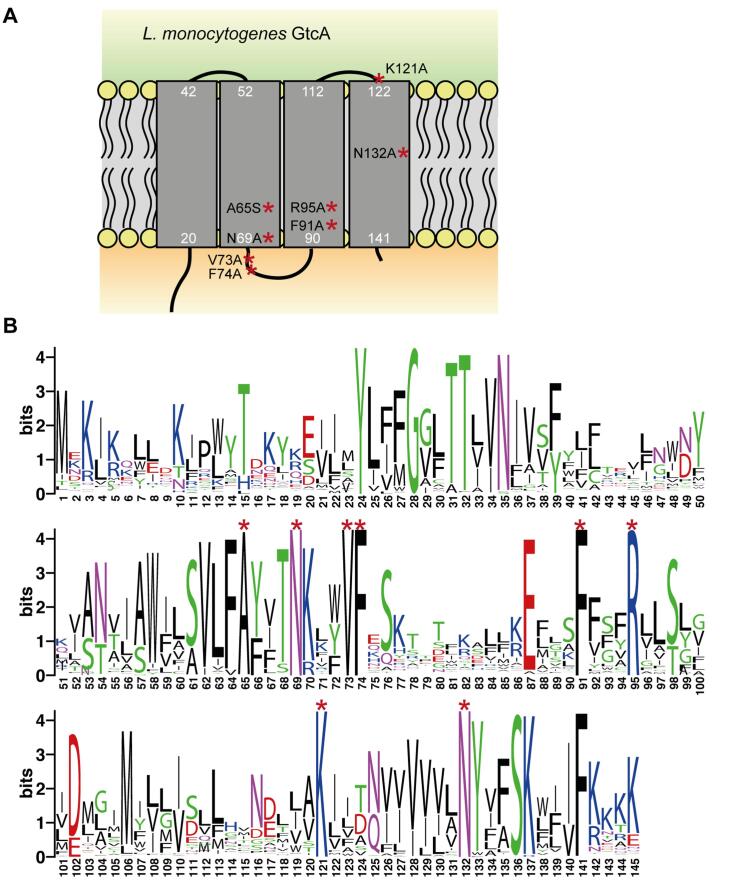
Membrane topology model and amino acid conservation of the L. monocytogenes 10403S GtcA protein. (A) Membrane topology model of the L. monocytogenes protein GtcA based on the prediction using the TMHMM version 2 server (Sonnhammer et al., 1998). Conserved amino acids mutated as part of this study are indicated. The numbers shown in white indicate the amino acids located at the predicted borders of the TM helices. (B) WebLogo motif of GtcA proteins. L. monocytogenes GtcA was used as query sequence in a BLASTP search and the sequences of the top 1000 GtcA homologs downloaded from the NCBI website (on 21.03.2019) and aligned using Jalview (Waterhouse et al., 2009). The alignment was used to generate the presented WebLogo motif (Crooks et al., 2004).